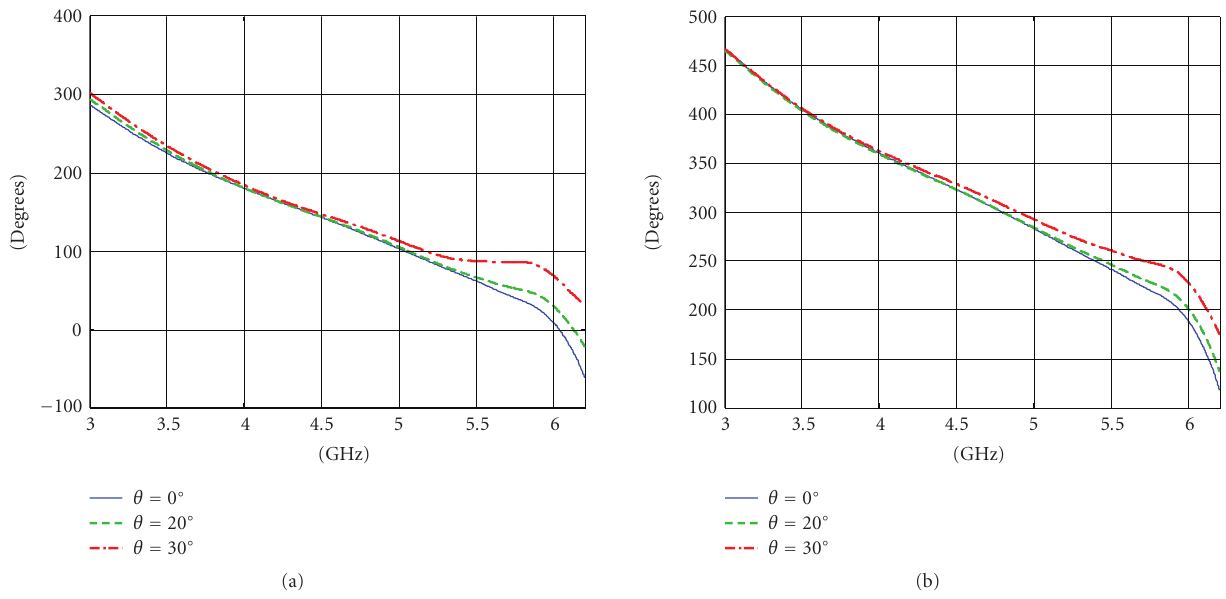
Figure 9: Simulated phase of the far-field (copolarization) in the E-plane (left) and in the H-plane at di ff erent angles in the main lobe.